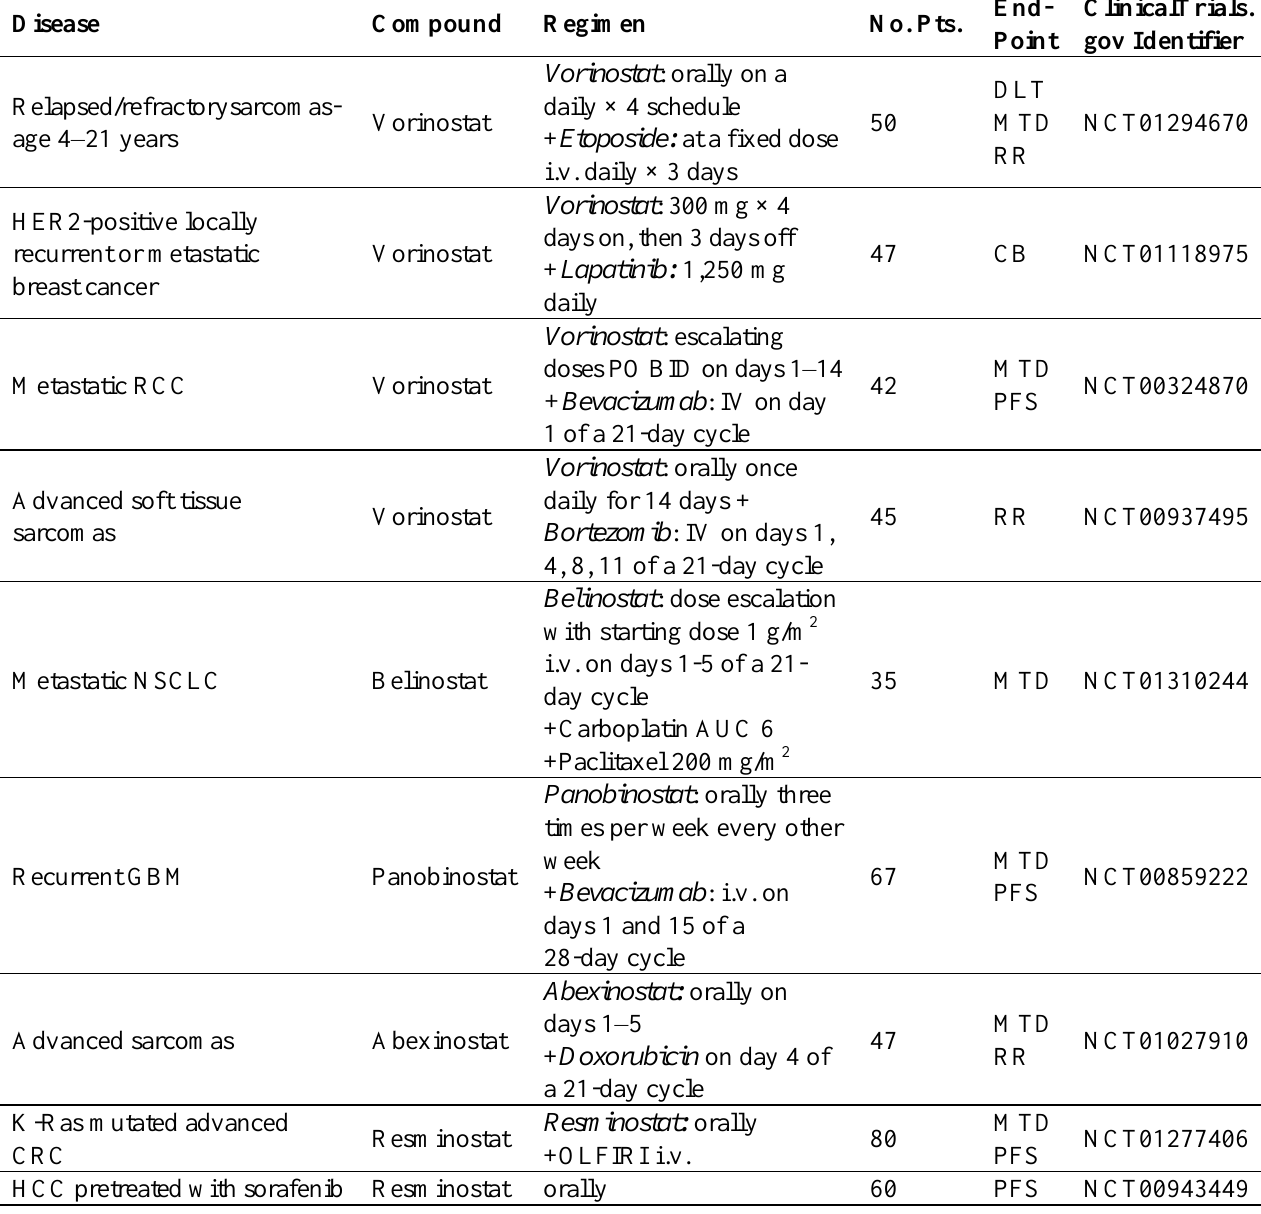
Table 6. Ongoing phase II clinical trials of Hb-HDACIs in solid tumors